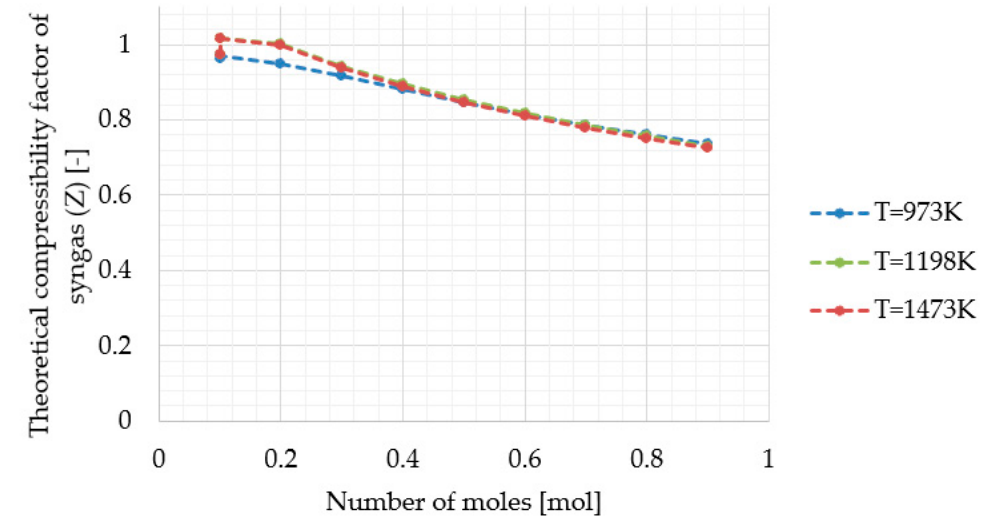
Figure 10. The theoretical value of compressibility coe ffi cient Z from the gasification of CO 2.